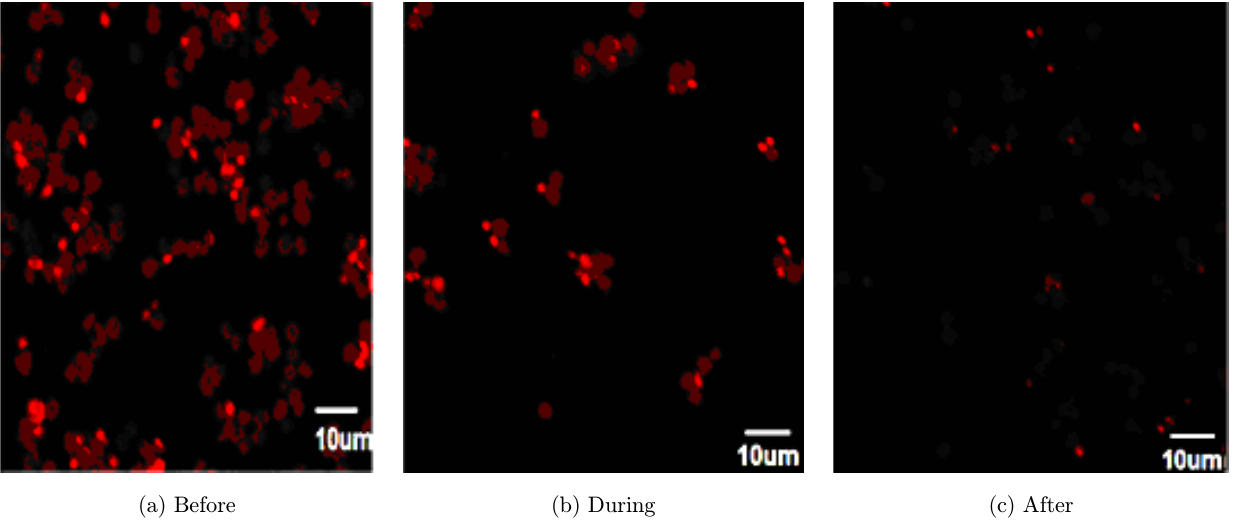
Fig. 6. CLSM images of destruction of AuNR-HM-DOX microcapsules (a) before, (b) during, (c) after continue NIR irradiation for 30 min.